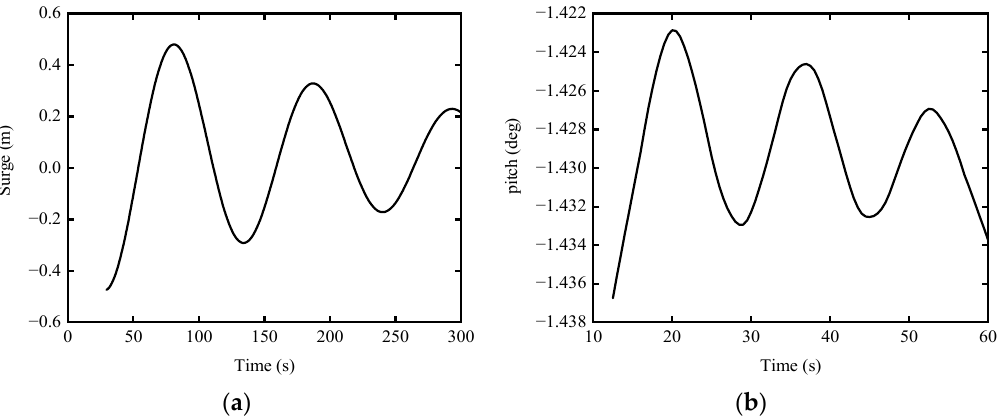
Figure 7. Platform response time series of surge and pitch in decay test: ( a ) Surge; ( b ) Pitch. Table 6. The natural periods and natural frequencies of the platform response.